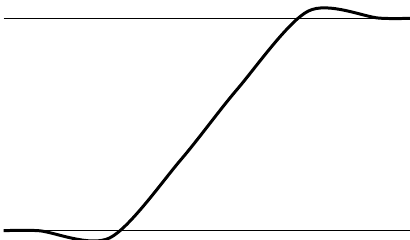
Figure 4. A visual explanation of the additional bends in the Wiener Bogen